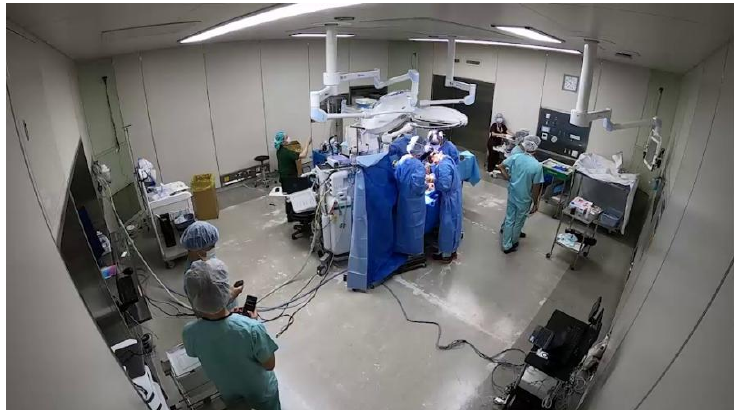
Figure 1. Operating